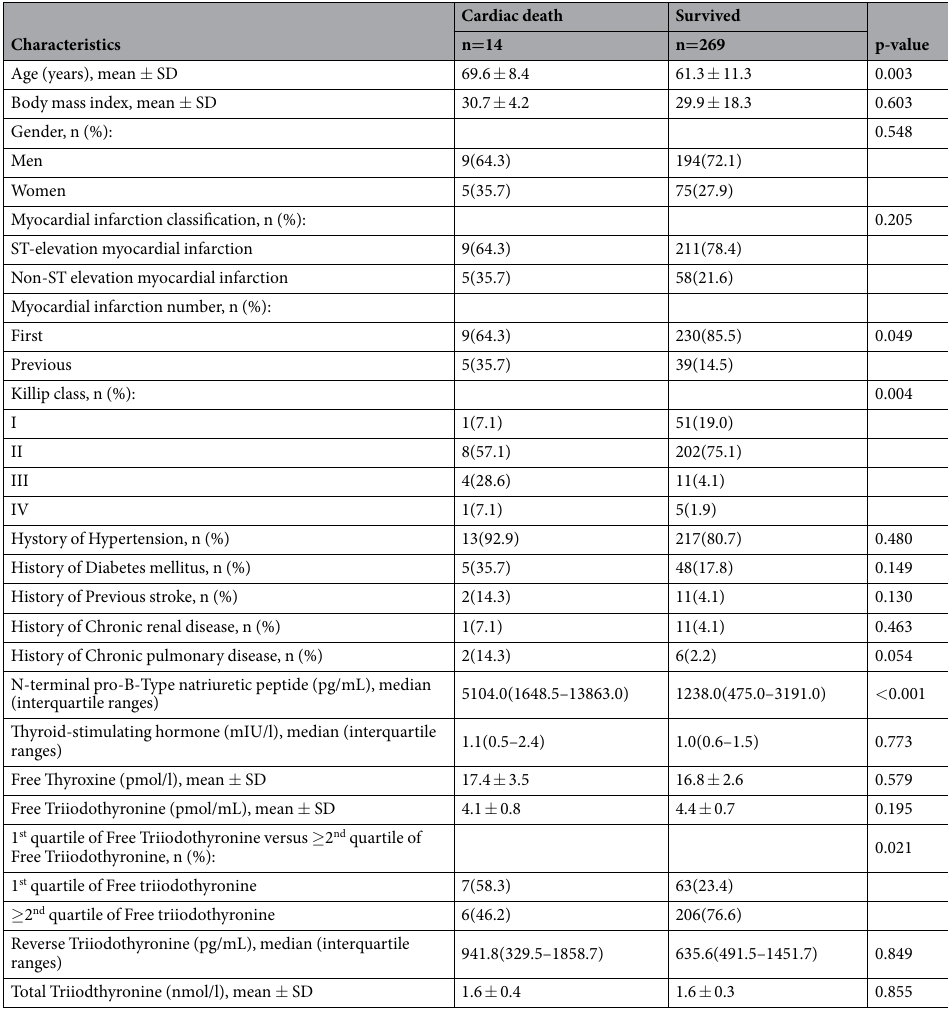
Table 3. Clinical characteristics of patients, who experienced cardiac death or survived due to MI. Values are presented as the mean ± SD, median (interquartile range), or percentage. p-values are presented for Student’s t test, Mann-Whitney’s U test, the Chi-square test or Fisher’s exact test as